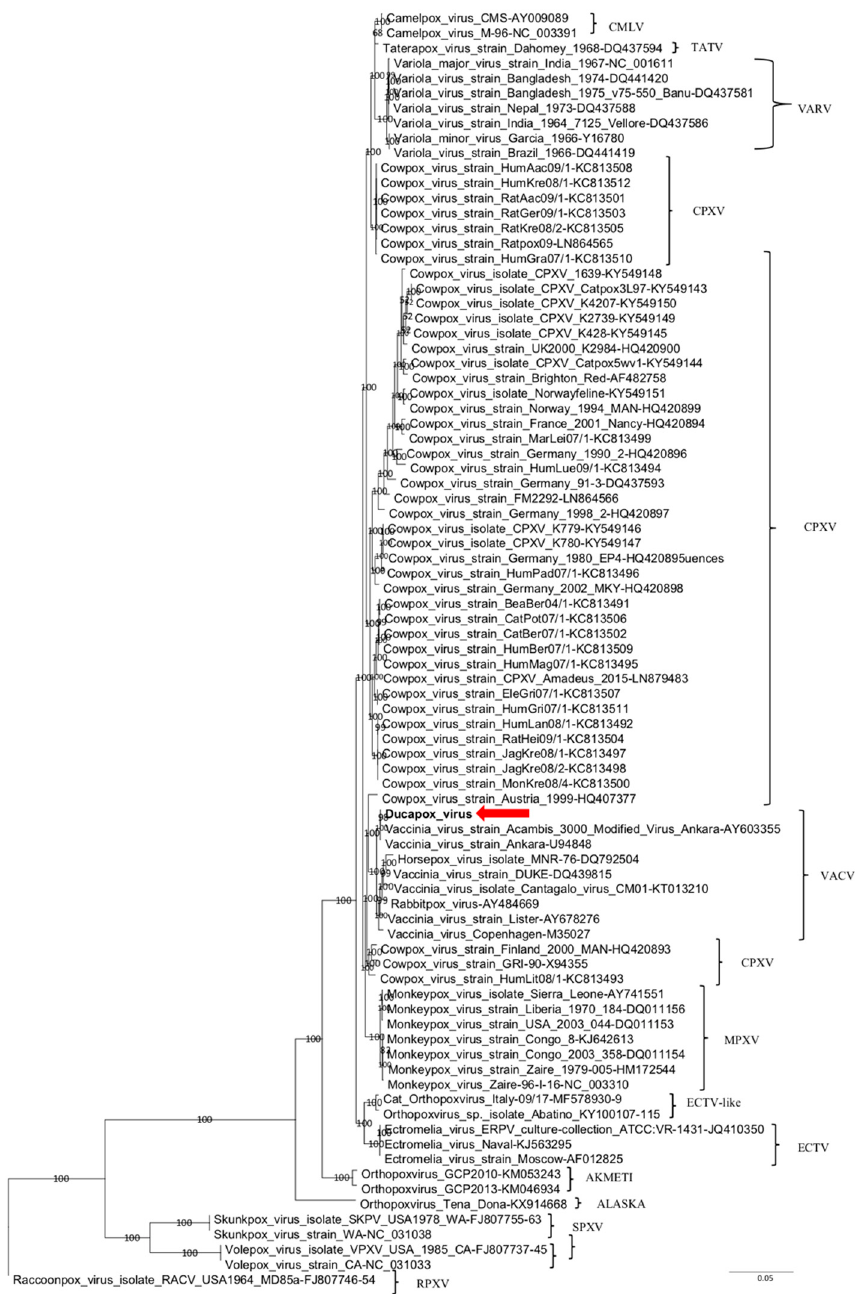
Figure 1. Phylogenetic relationship of extant OPXVs with Ducapox vaccine. Phylogenetic tree shows concatenated alignment of nine coding gene (A7L, A10L, A24R, D1R, D5R, E6R, E9L, H4L, and J6R) sequences of Orthopoxvirus . Gene designations refer to the VACV-COP genome (GenBank accession No. M35027). Posterior probability values > 0.95 are indicated on the tree nodes. The red arrow indicates the Ducapox vaccine (this study). Raccoonpox virus strain MD85A was used as an outgroup. Scale bar indicates nucleotide substitutions per site. CMLV, Camelpox virus ; CPXV, Cowpox virus ; ECTV, Ectromelia virus ; MPXV, Monkeypox virus ; RPXV, Raccoonpox virus ; SPXV, Skunkpox virus ; TATV, Taterapox virus ; VACV, Vaccinia virus ; VARV, Variola virus ; VPXV, Volepox virus .